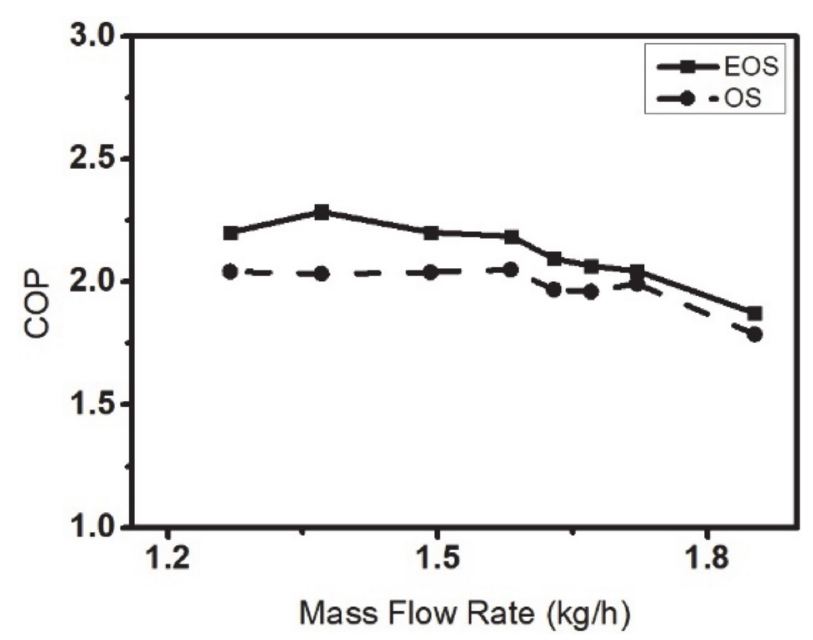
Figure 7. COP with variation of mass flow